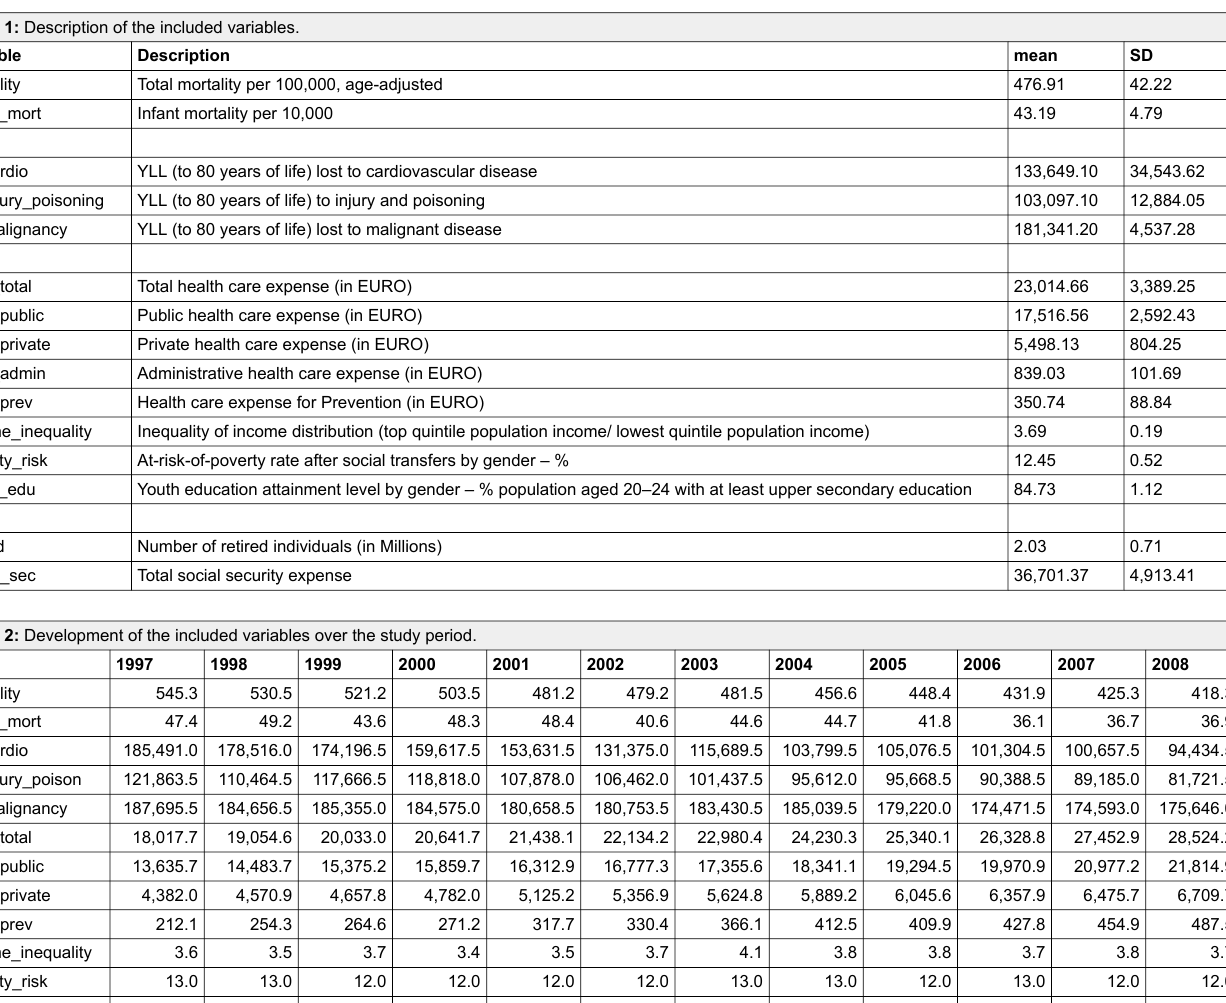
Table 1: Description of the included variables.